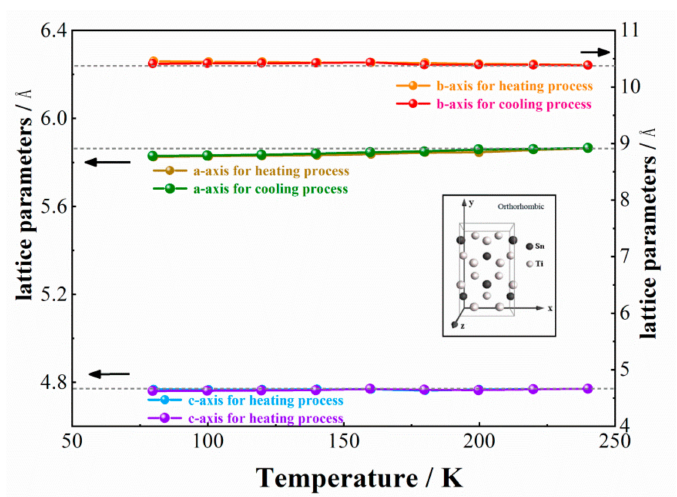
Figure 7. Temperature dependence of lattice parameters a, b and c of orthorhombic Ti 3 Sn during cooling and heating processes, in which the schematic unit cell is also showed.